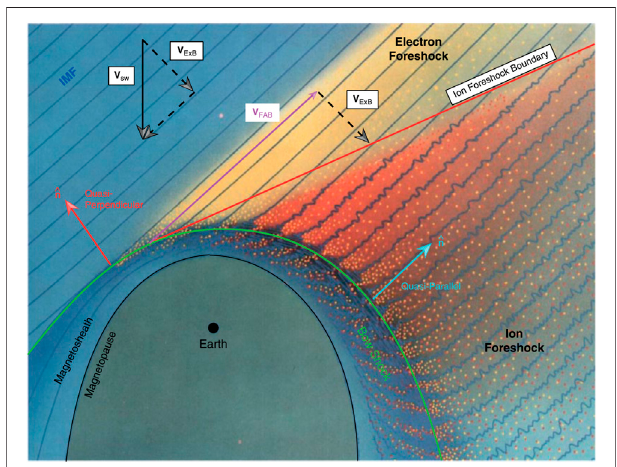
FIGURE 1 | Foreshock con fi guration showing incident solar wind magnetic fi eld (blue lines), impinging on the bow shock (green curved line), producing backstreaming ions (yellow dots), leaked magnetosheath ions (red dots), and upstream waves (wavy blue lines). The ion foreshock boundaryisshownasthered line.FigureisfromWilson,(2016),adaptedfrom Tsurutani and Rodriguez (1981), and is reproduced with permission from The American Geophysical